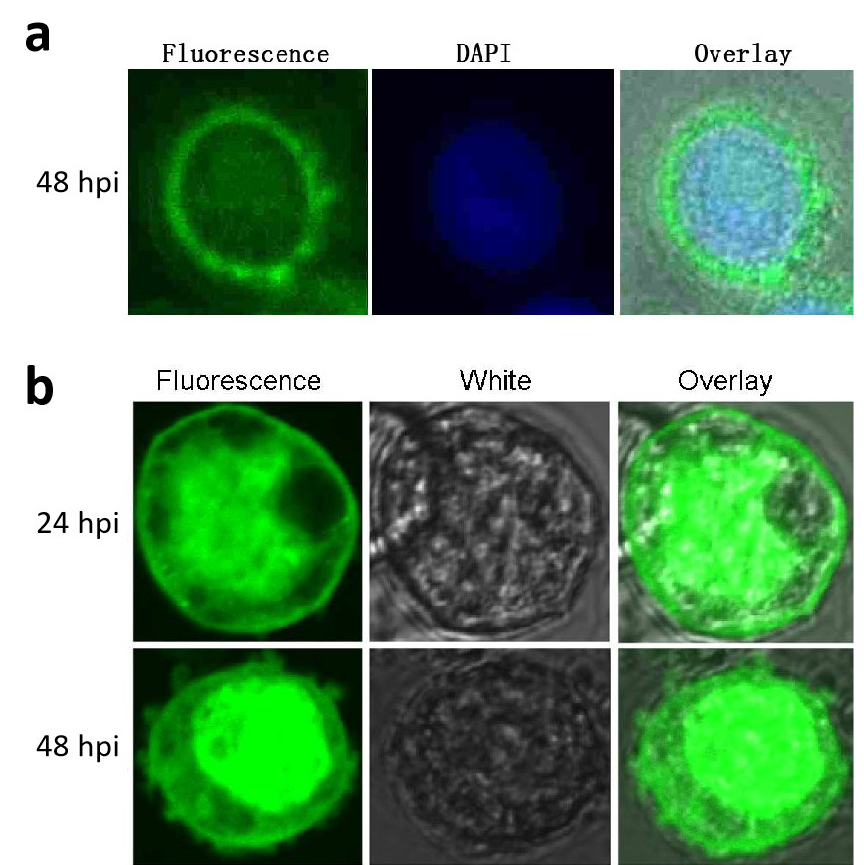
Figure 3. Subcellular localization of BmNPV p26 . ( a ) Localization of p26 in BmNPV-infected BmN cells. The cells were collected at 48 hpi, reacted with anti- p26 serum, treated with EGFP-conjugated goat anti-rabbit IgG, and viewed under a confocal laser fluorescence microscope. In order to visualize the nucleus, the cells were also stained with DAPI (blue). ( b ) Localization of the over-expressed fusion protein EGFP-p26 in recombinant BmNPV infected BmN cells. EGFP-fused p26 was driven by the AcMNPV ph promoter and over-expressed in BmN cells. At 24 and 48 hpi, the cells were directly collected for fluorescence microscopy analysis.